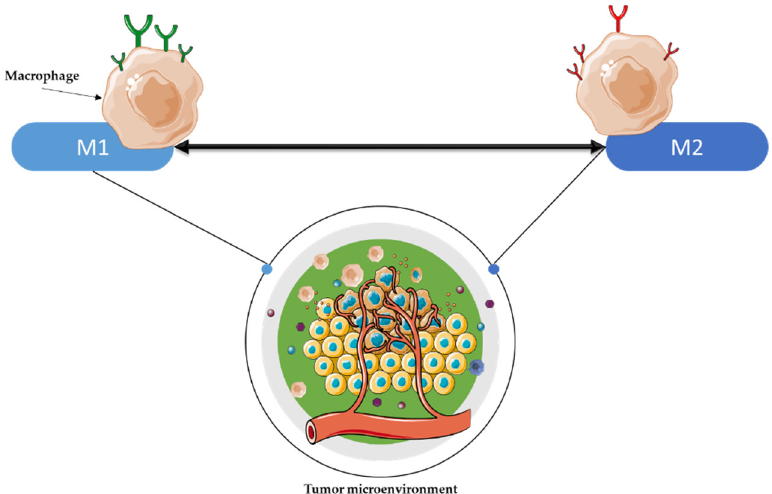
Figure 4. – Interactions within the tumor microenvironment (TME) can switch macrophages profile. Figure 4. Interactions within the tumor microenvironment (TME) can switch macrophages